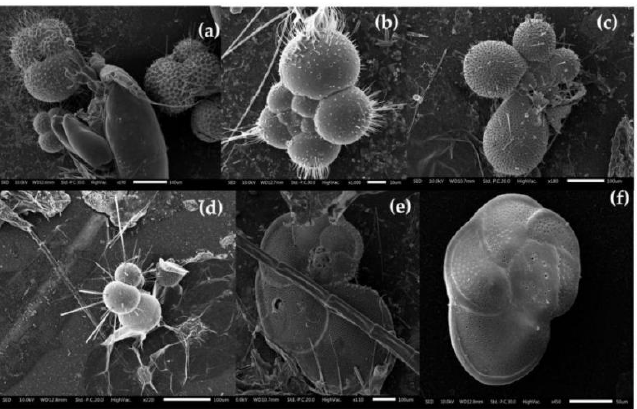
Figure 4. Scanning electron micrographic plates of some planktonic foraminifera species of EIO [4]. ( a ) Globigerinoides ruber , ( b ) Orcadia riedeli , ( c ) Globigerinella calida , ( d ) Hastigerina pelagica , ( e ) Globoro- talia menardii, ( f ) Globorotalia tumida . Scale bar: 10 µm, 50 µm, and 100 µm. Images were adapted with permission from Munir et al. [4]. Copyright 2018 Chinese Society for Oceanography and Springer.